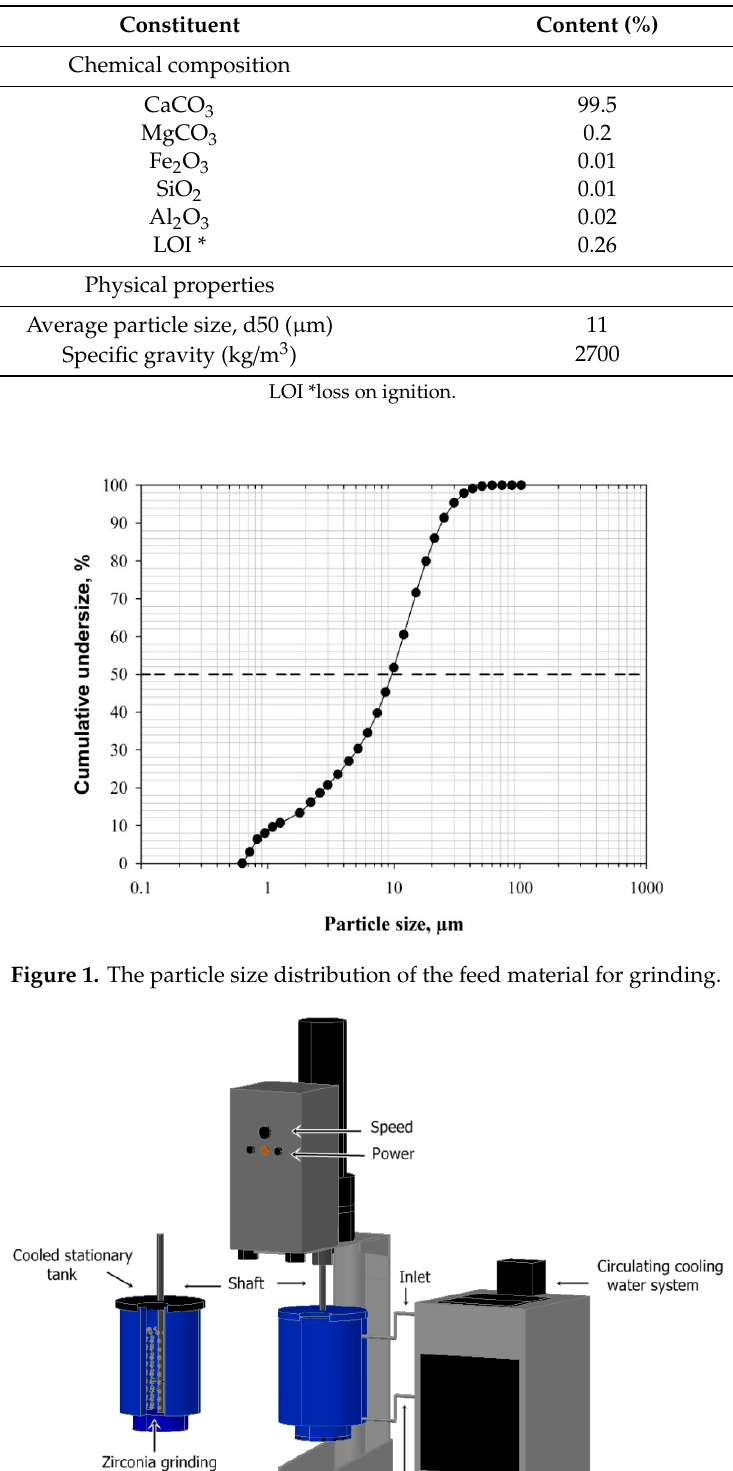
Table 1. The chemical composition and basic physical characteristics of the calcite specimen.